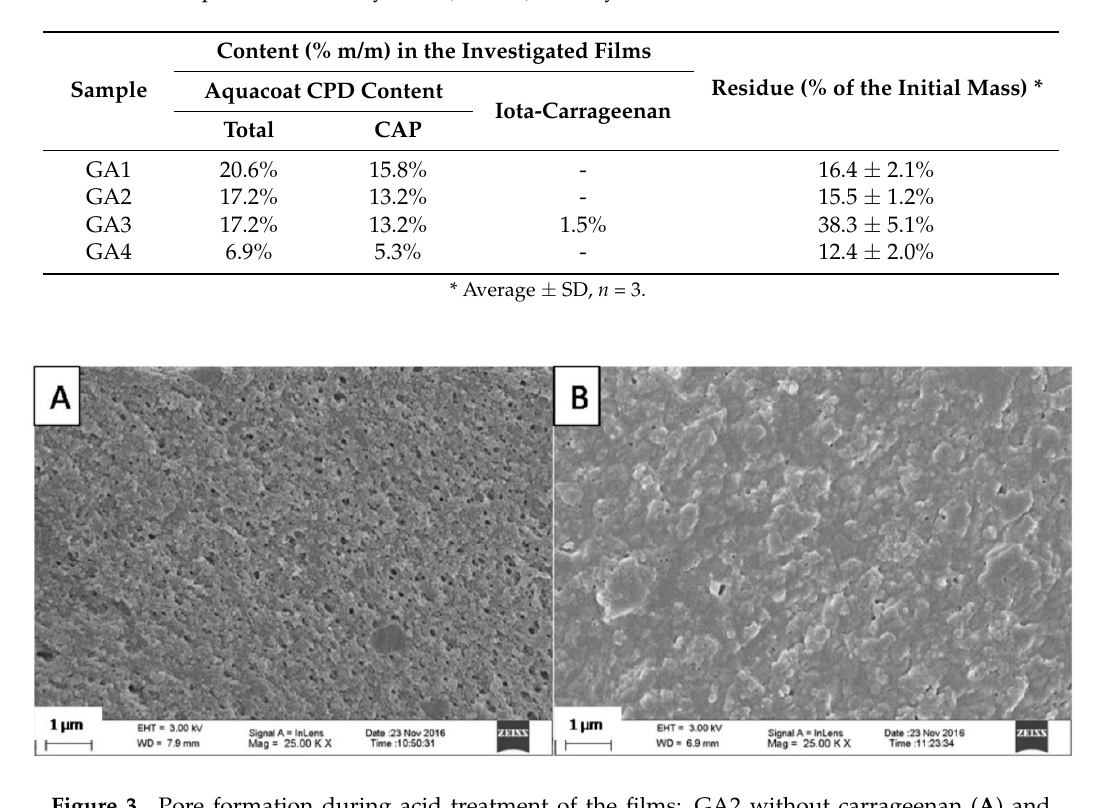
Table 2. Composition of the dry films (%m/m) and dry residues recovered after 3 h in 0.1 M HCl.